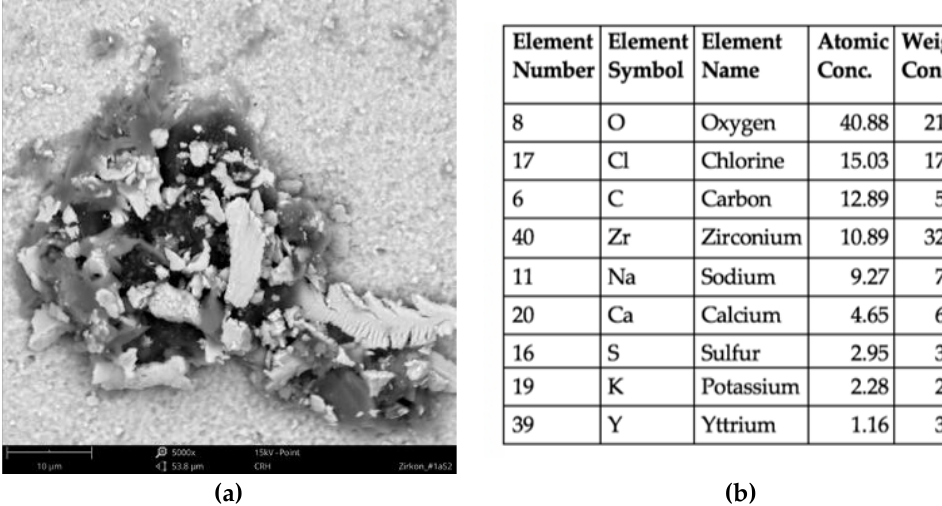
Figure 4. ( a ) SEM of debris on ZrO 2 monotype specimen #1a before cleaning (5000 × ); ( b ) energy dispersive X-ray spectroscopy (EDX) analysis of respective SEM and chemical elements of contamination. Table 2. Chemical analysis of particulate residues on IPSemax / Ti-Base samples before ultrasonic cleaning by element and maximum / minimum atomic concentration.